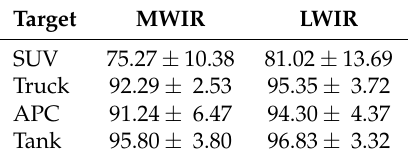
Table 2. The fusion results with two robots and different types of target.